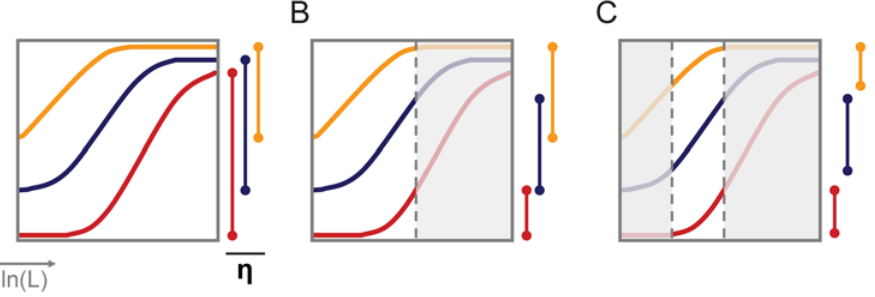
Figure 7. The accessibility of the riboswitch response curve depends on application category and associated system restrictions. Categories include an inducible regulatory system with (A) no ligand limitations or (B) a ligand concentration upper limit, and (C) an autonomous regulatory system with defined lower and upper limits for the ligand concentration. The accessible dynamic range ( g ) for each response curve depends on the system restrictions. The properties of other components in the network will dictate which riboswitch design best meets performance requirements. For example, under the autonomous regulatory system (C) the red curve may be more appropriate for the regulation of cytotoxic genes, the orange curve may be more appropriate for the regulation of enzymes with low catalytic activity, and the blue curve may be more appropriate for regulatory networks that require a large change in protein levels.